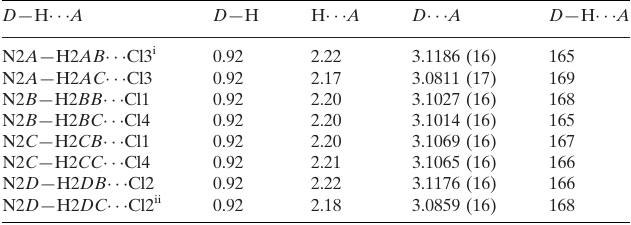
Oxford Diffraction Xcalibur diffractometer with Ruby